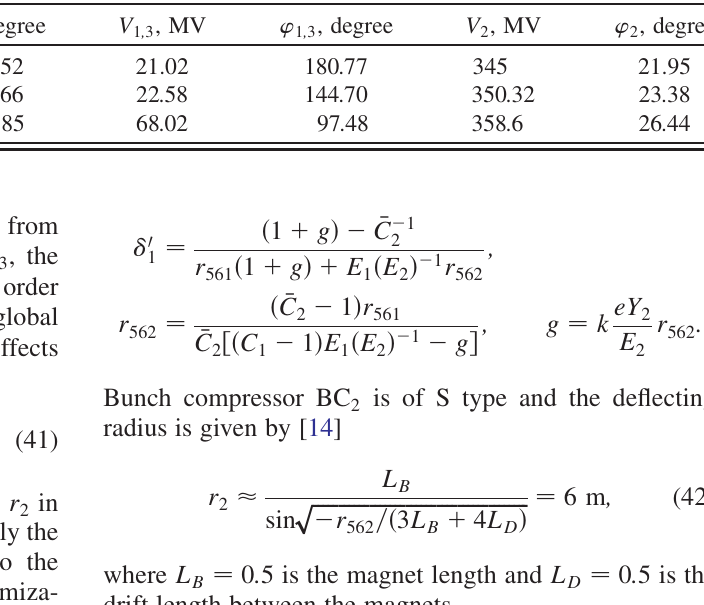
TABLE II. The rf parameters in the working point.